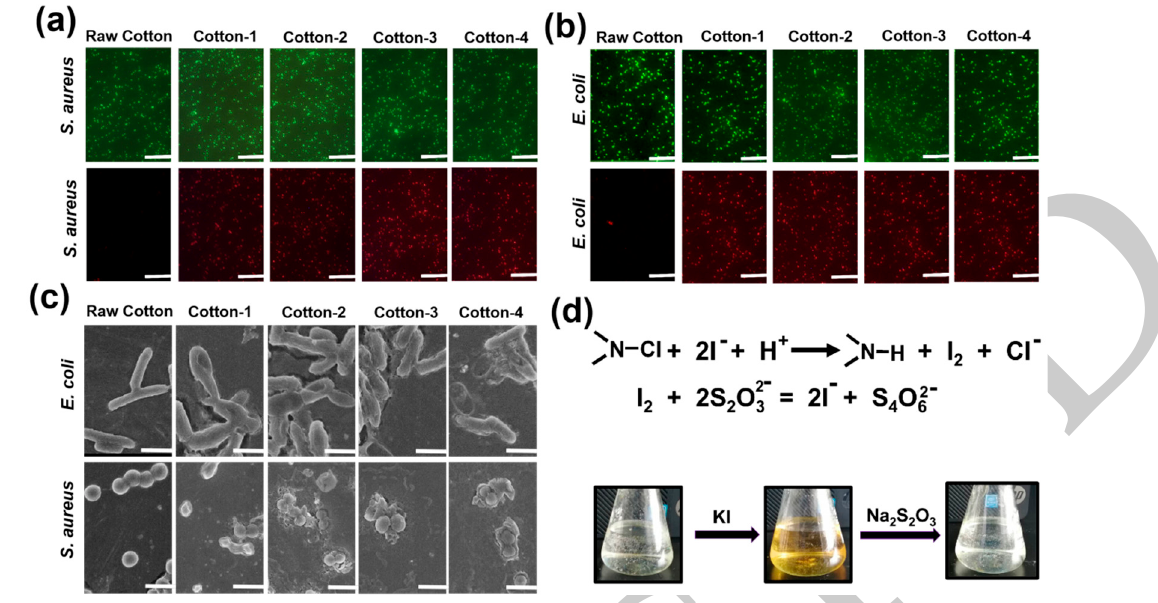
Figure 6. ( a ) The assessment of live/dead S. aureus ( a ) and E. coli ( b ) treated with different cotton fabrics. The bar is 20 µm, green dots represent alive and dead S. aureus or E. coli ; the red dots represent dead S. aureus or E. coli . ( c ) The SEM images of bacterial cell morphology exposed to different cotton samples. ( d ) Oxidation-reduction reactions and the corresponding color change involved in the iodometric/thiosulfate titration.